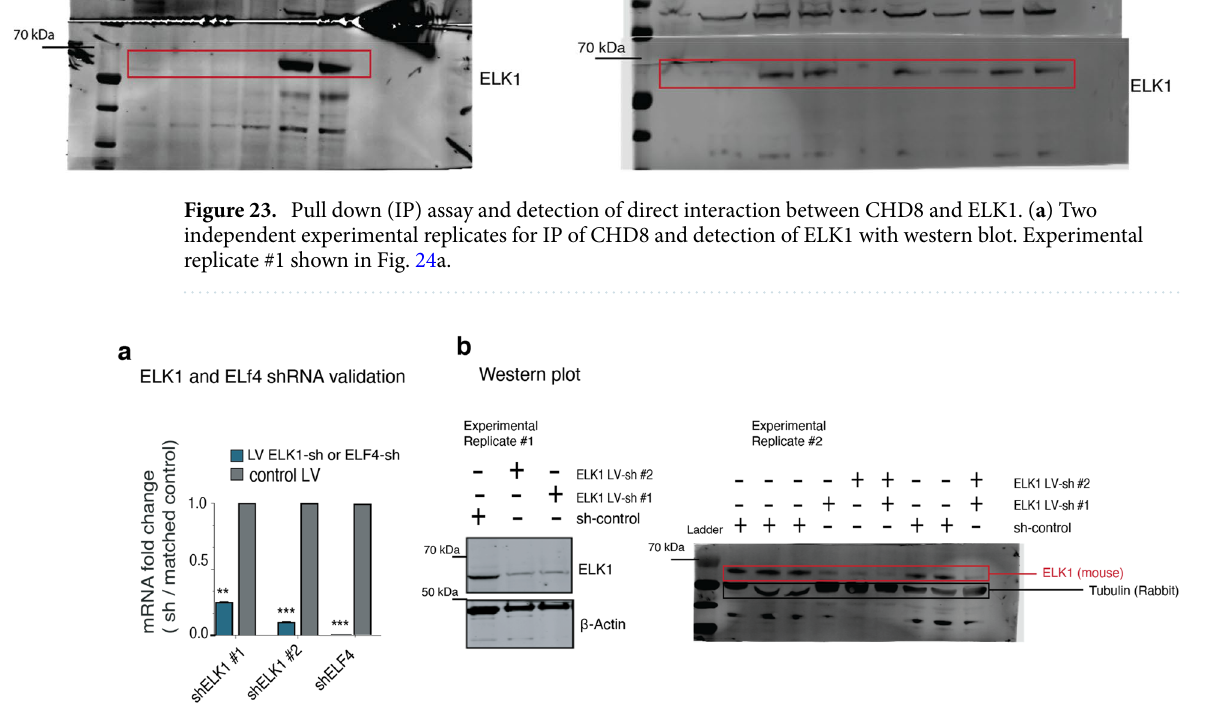
Figure 24. ELK1 RNA knockdown and measurements of protein level in neurons. ( a ) Bar graph shows knockdown of ELK1 and ELF4 genes with a short hairpin (shRNA) and measurement of mRNA. ( b ) Western blot shows knockdown of ELK1 with two hairpins and the reduction of ELK1 protein in neurons (two independent experimental